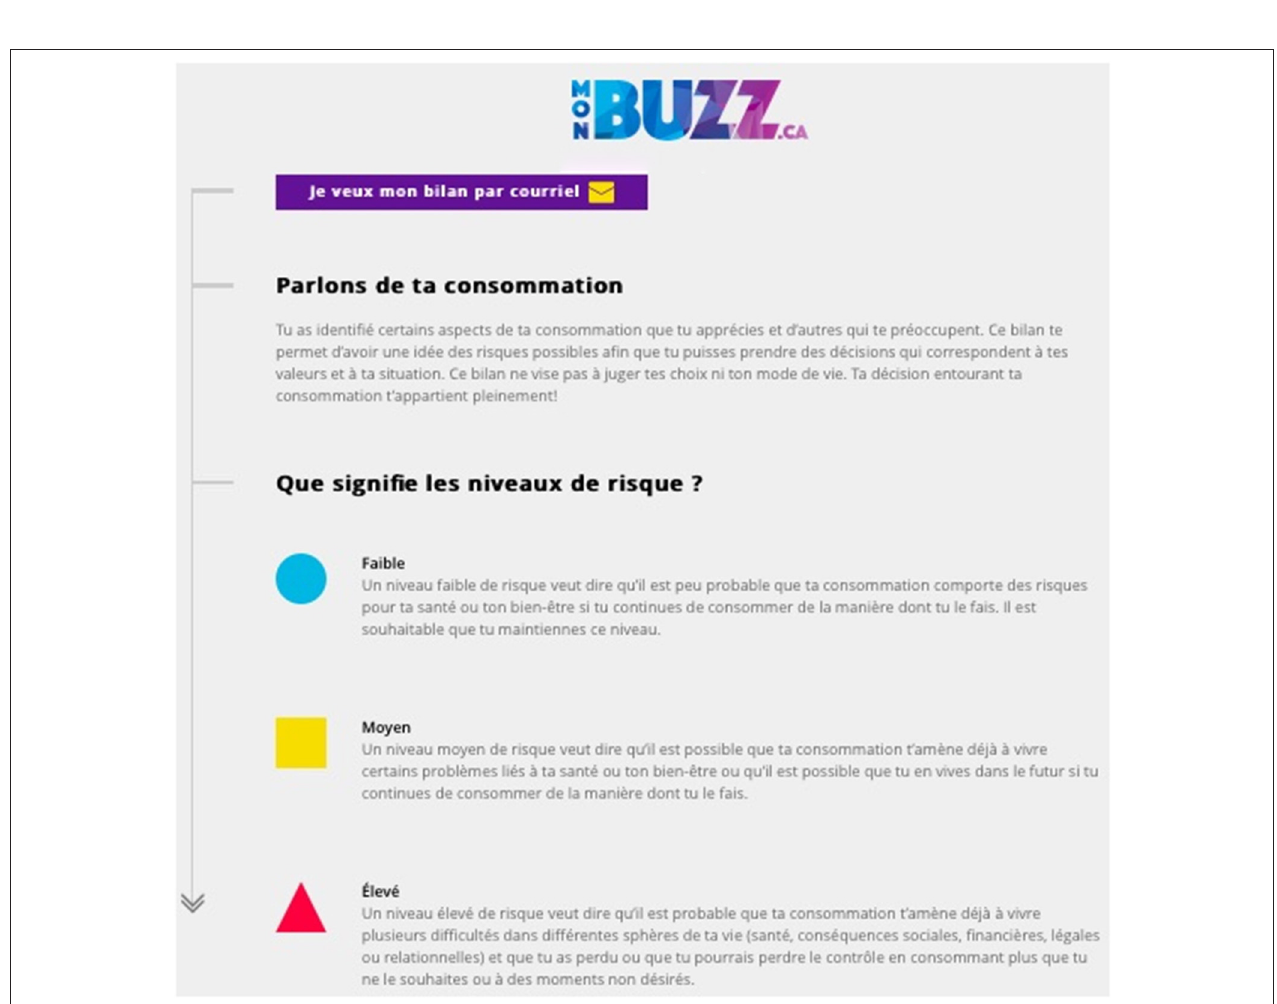
FIGURE 3 | Example of feedback.